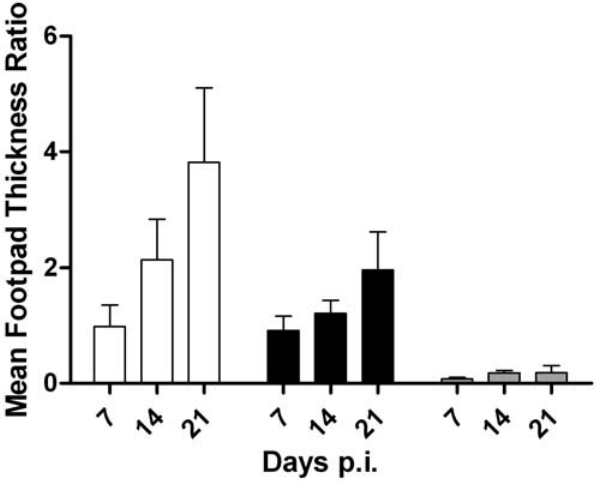
Figure 4. In vivo efficacy of disulfiram in a murine footpad model. Balb/ c mice were infected with 10 6 stationary phase L. major promastigotes (s.c.) and treated three days later with vehicle (open square), disulfiram (160 mg/kg)(black square) or amphotericin B (gray square). Footpad thickness was measured every 7 days over a 21 day period. Data are presented as mean 6 SEM